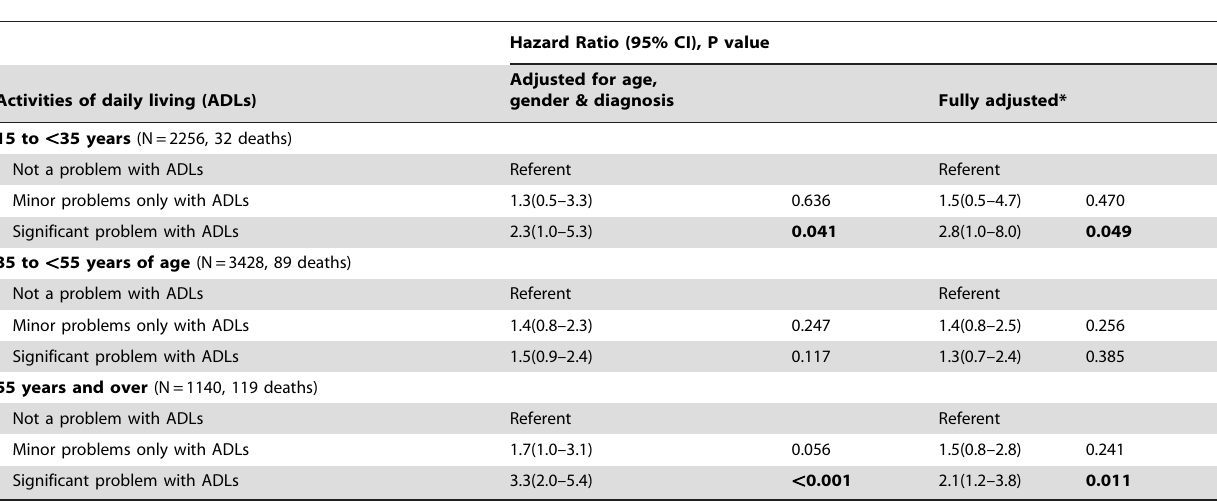
Table 4. Association between activities of daily living (ADLs) and all-cause mortality in individuals with serious mental illness stratified by